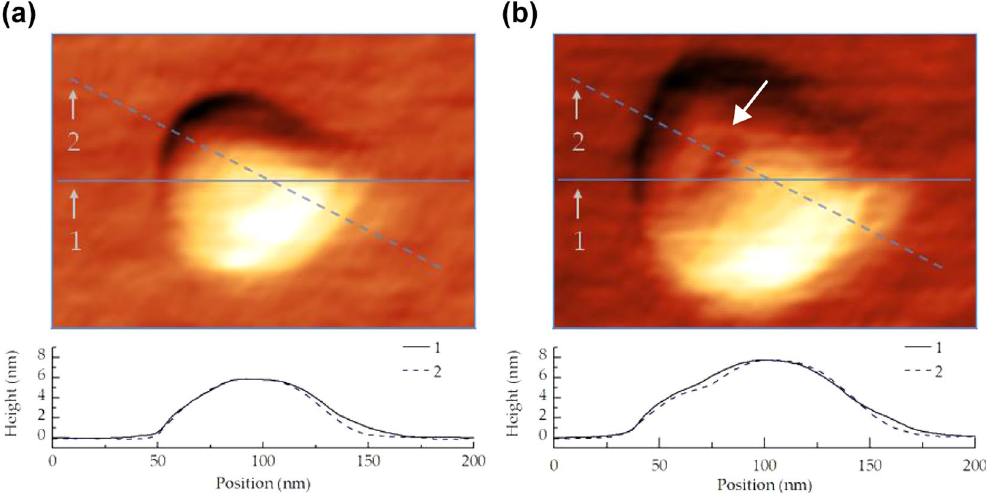
Figure 2. AFM images of a Si wafer that was implanted with 60 keV Si 2 + ions at ( a ) 2 × 10 5 ions per spot and ( b ) 6 × 10 5 ions per spot and the line profiles corresponding to lines 1 and 2 in the respective images. Note the development of a small surface crater in ( b ) denoted by the white arrow. Adapted from ref. 32